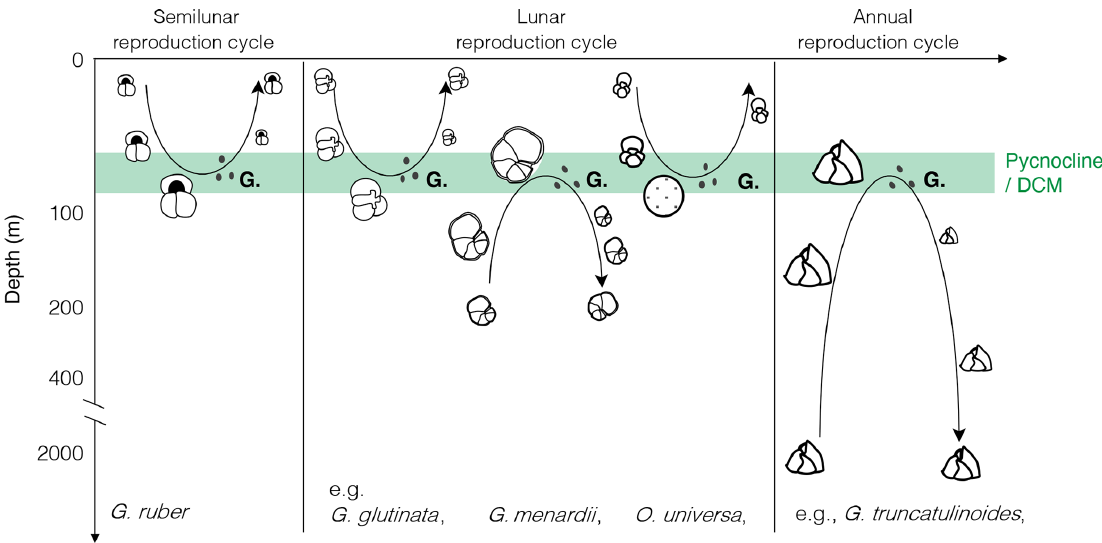
Figure 1. Canonical view of the reproductive strategy of selected species of planktonic foraminifera with synchronised reproduction and ontogenetic vertical migration, modified after the idealised schemes proposed by Hemleben et al. (1989) and Schiebel and Hemleben (2005, 2017). “G.” indicates gametogenesis, with black dots depicting the